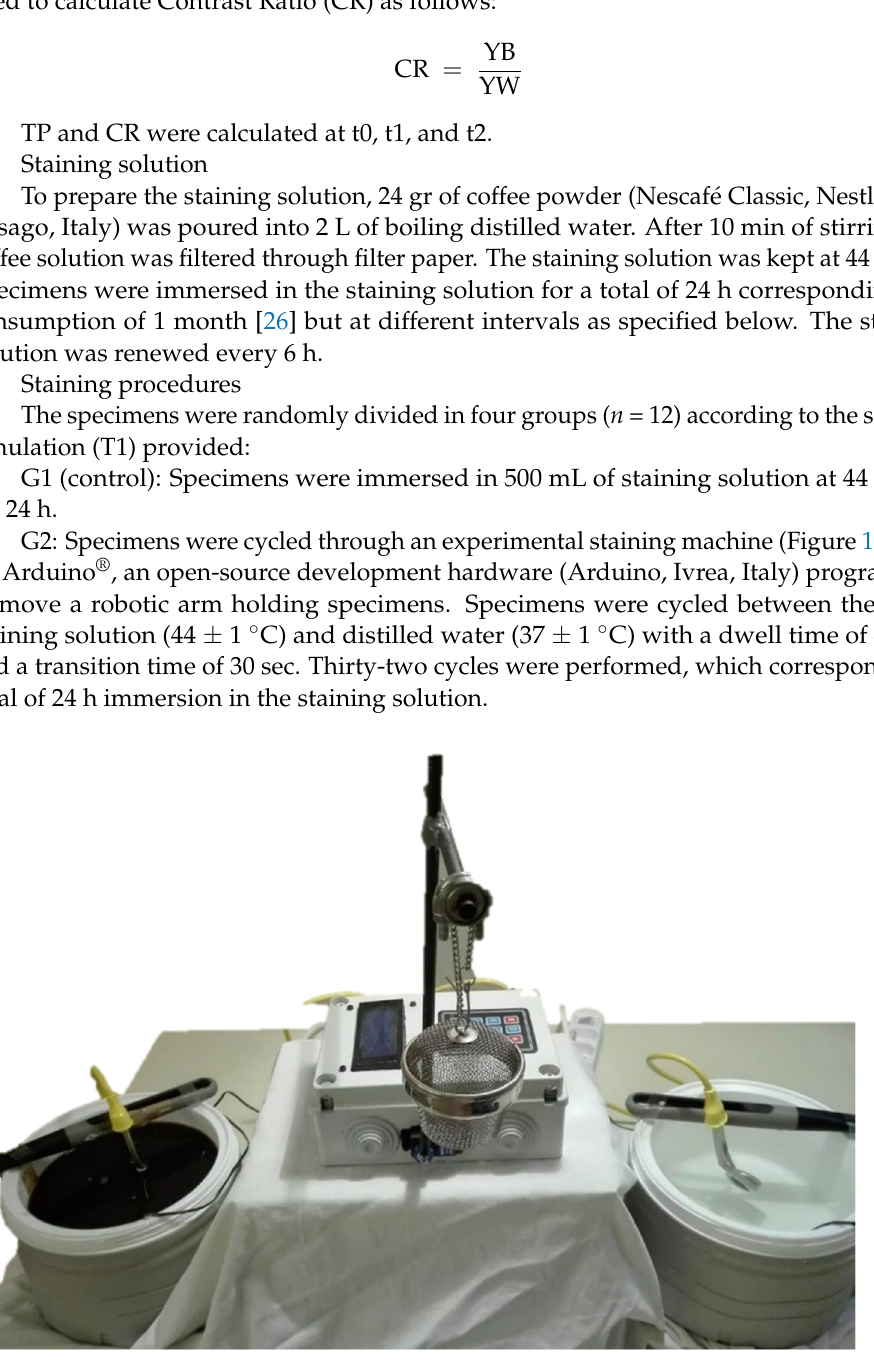
Figure 1. The experimental staining machine. G3: Specimens were treated as in G2 plus adding, after every immersion in the staining solution, a brushing simulation (7.5 sec) with an experimental brushing machine.